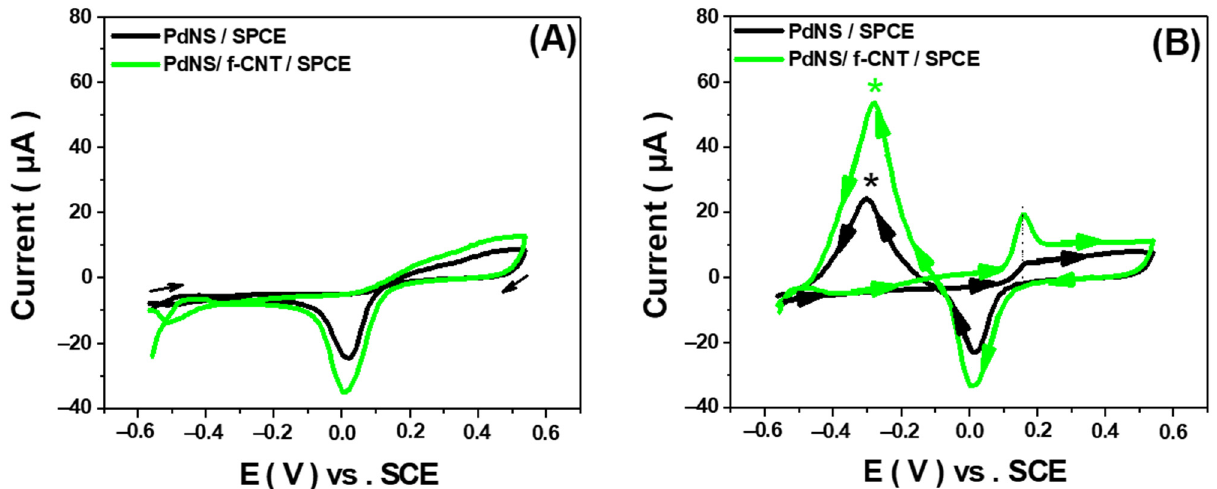
Figure 2. CVs of PdNS/SPCE ( black line ) and PdNS/f-CNT/SPCE ( green line ) in 0.1 M PBS (pH 7.4), without ( A ) and with ( B ) 20 mM glucose, scan rate 10 mV s − 1 . (*) oxidative peaks appeared during the cathodic scan. All CV experiments were performed after the electrodeposition of PdNS at − 0.2 V vs. SCE for 1000 s in a 0.05 M HClO 4 and 0.25 M H 2 SO 4 containing 1 mM Pd 2+